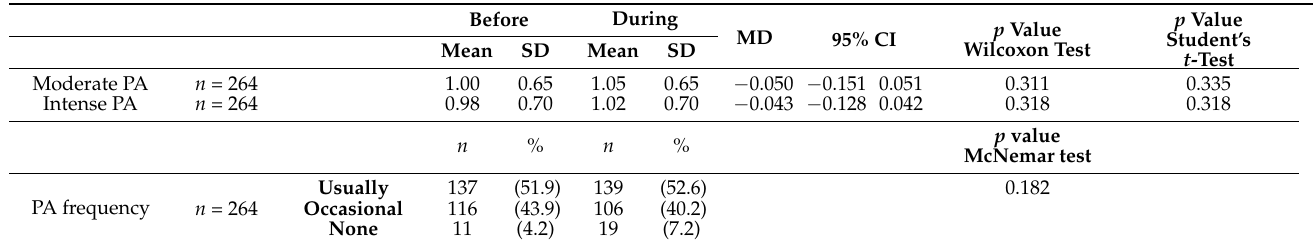
Table 3. Moderate and intense physical activity (PA) per week and PA frequency before and during the COVID-19 pandemic.